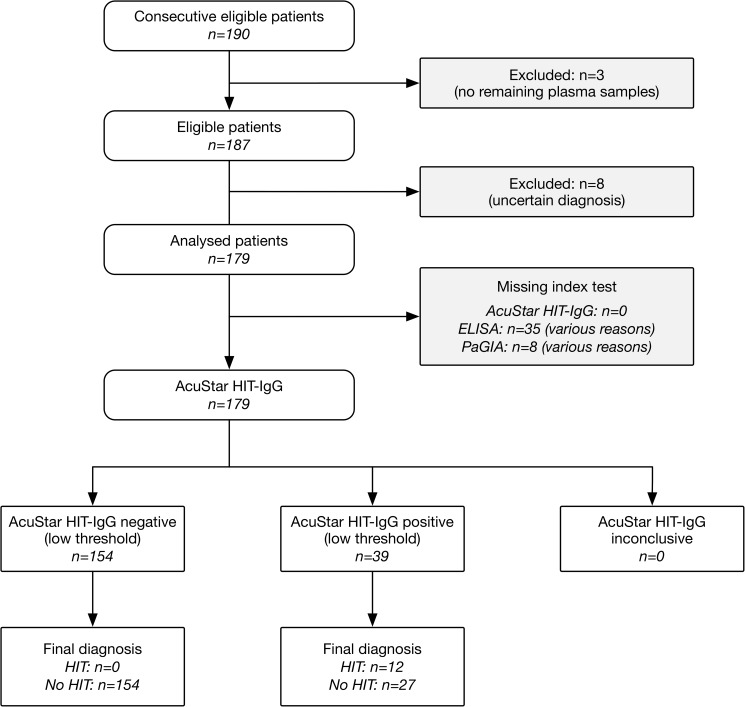
Flow of participants.